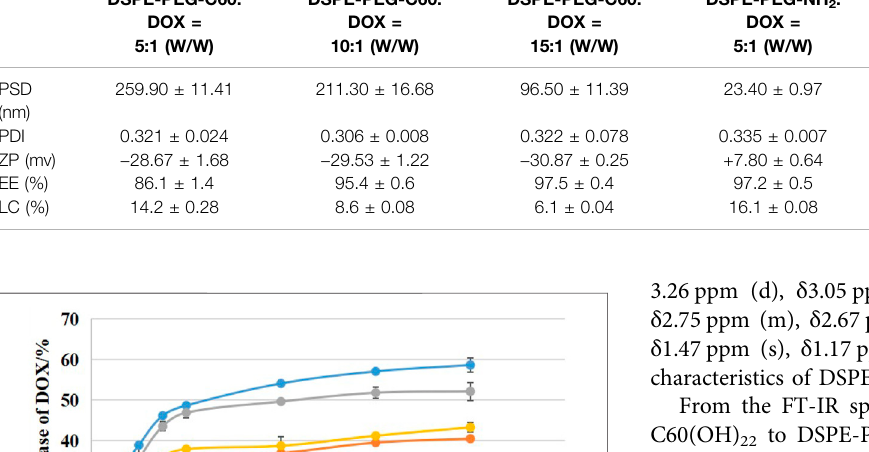
TABLE 1 | Particle size distribution (PSD), PDI, zeta potential (ZP), encapsulation ef fi ciency (EE), and drug loading content (LC) of micelles. DSPE-PEG-C60: DOX =